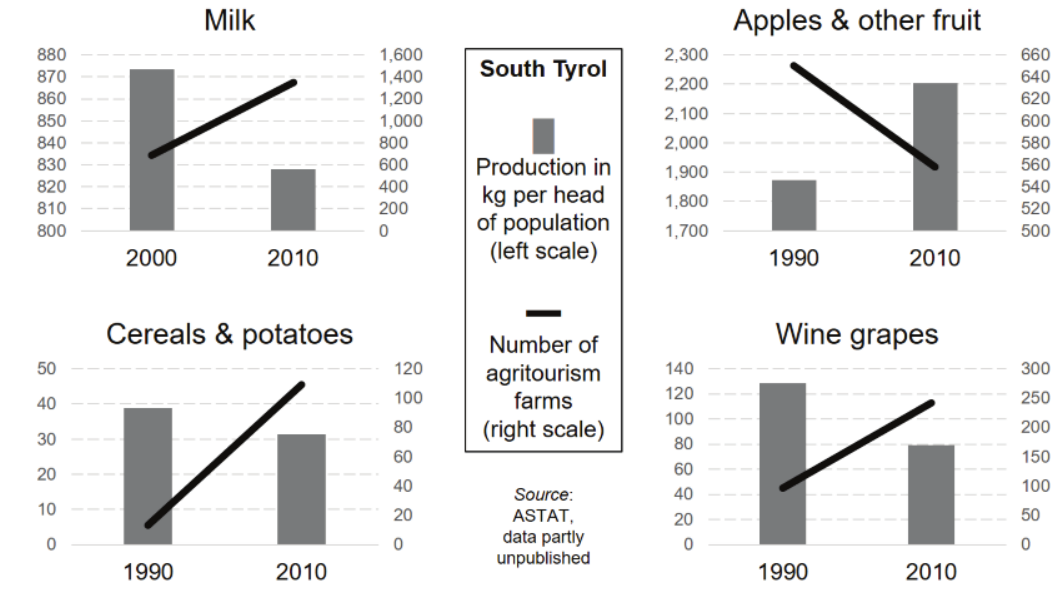
Figure 3: Correlation between sub-sector farm output and agritourism activity in South